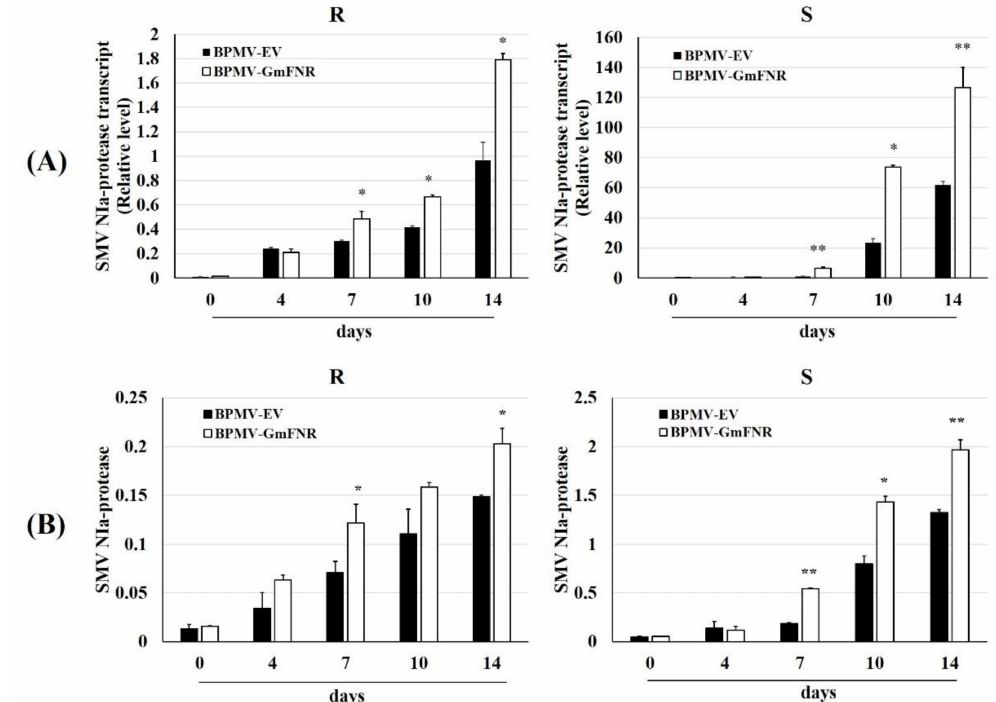
Figure 5. Soybean mosaic virus (SMV) accumulation in control (BPMV-EV) and silencing (BPMV-GmFNR) plants of resistant (R) and susceptible (S) lines. ( A ) qRT-PCR analysis of SMV NIa protease transcripts ( B ) DAS-ELISA analysis of SMV NIa protease. Samples were collected at 0, 4, 7, 10, and 14 days post inoculation (dpi). Statistical significance “*” and “**” indicate p < 0.05 and p < 0.01, t